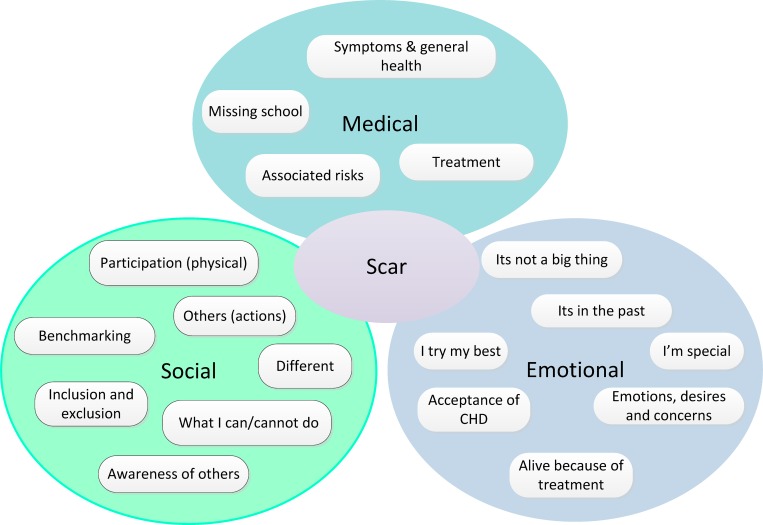
Codes and themes.